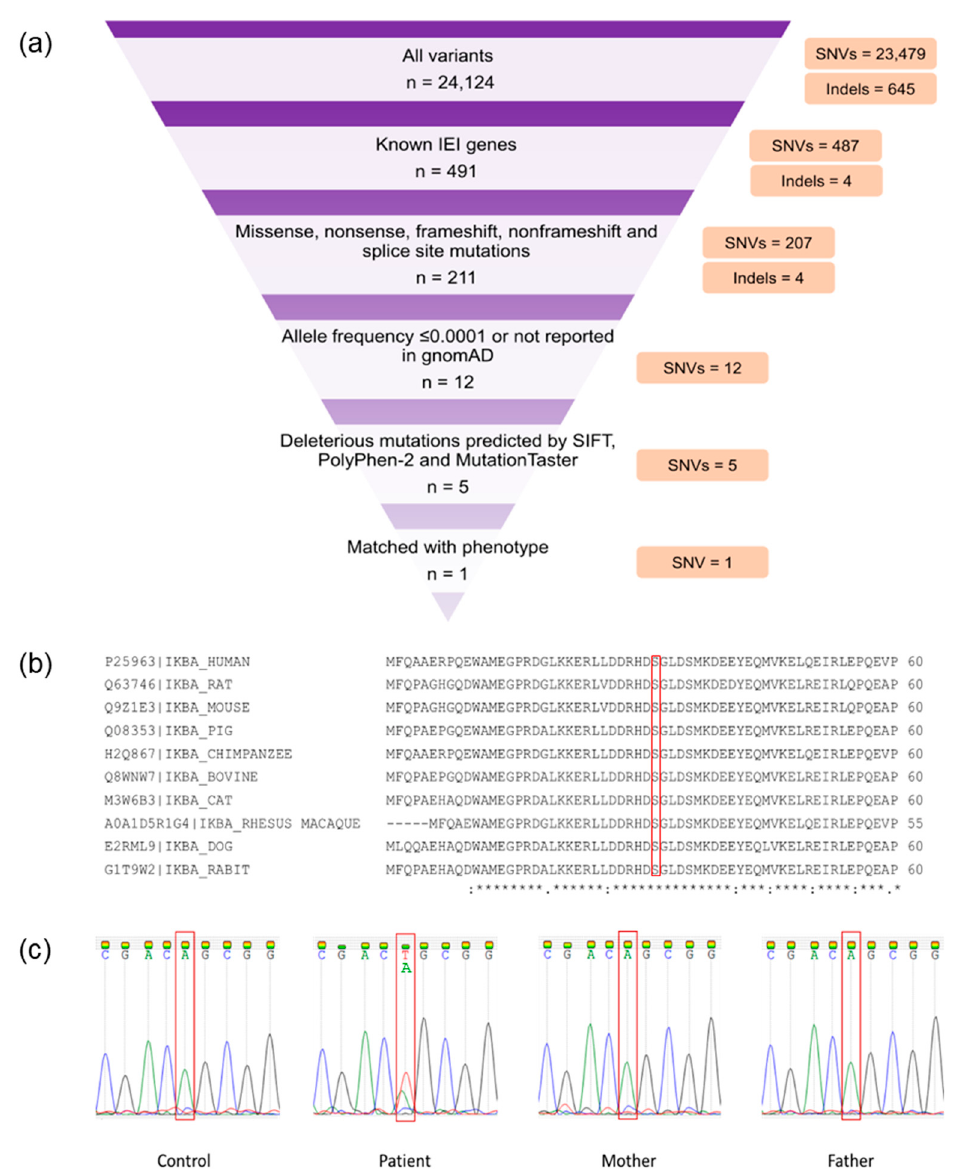
Figure 1. Whole-exome sequencing (WES) findings and variant validation. ( a ) WES filtering diagram. ( b ) Conservation analysis of NF- κ B inhibitor α (I κ B α ). The red bracket indicates the mutation site (p.Ser32). A fully conserved residue is indicated by an asterisk sign (*). A colon sign (:) indicates conservation between groups of strongly similar properties, while a period sign (.) indicates conservation between groups of weakly similar properties. ( c ) Familial segregation analysis by Sanger sequencing. The red bracket shows the mutation site (c.94A). The patient had a de novo heterozygous Ser32Cys (c.94A > T) mutation.